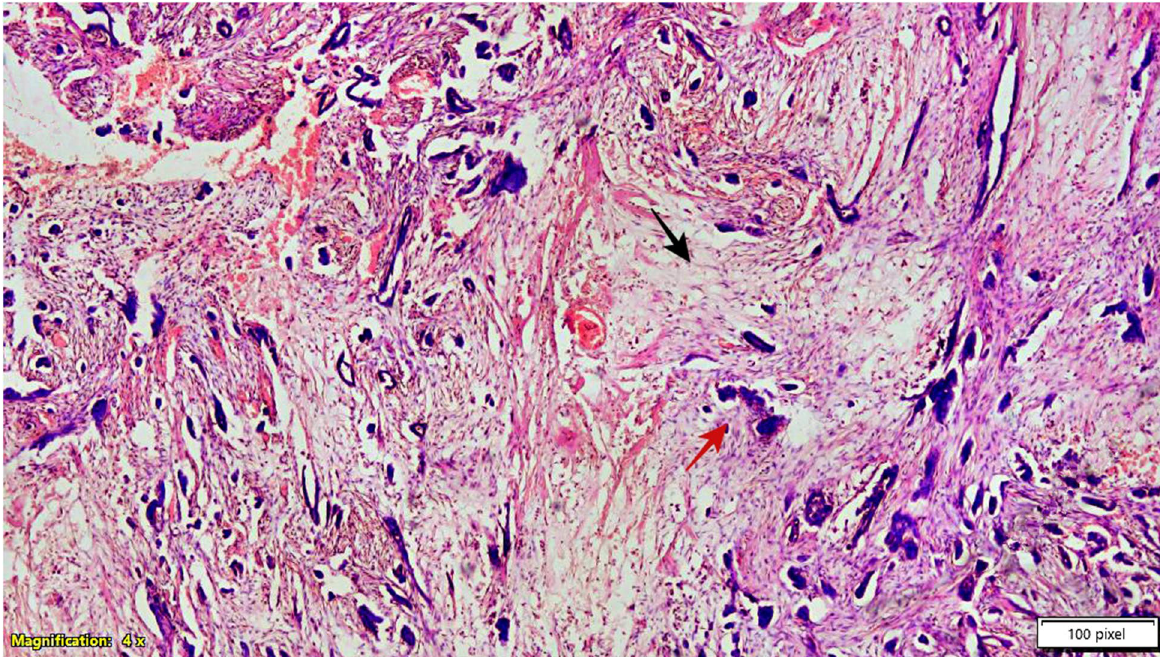
Fig. 3 Immature desmoplastic reaction. Loose stroma with plump fibroblasts (black arrow) with the presence of few cluster of poorly differentiated tumor cells (red arrow) (H&E, 4 ) ×